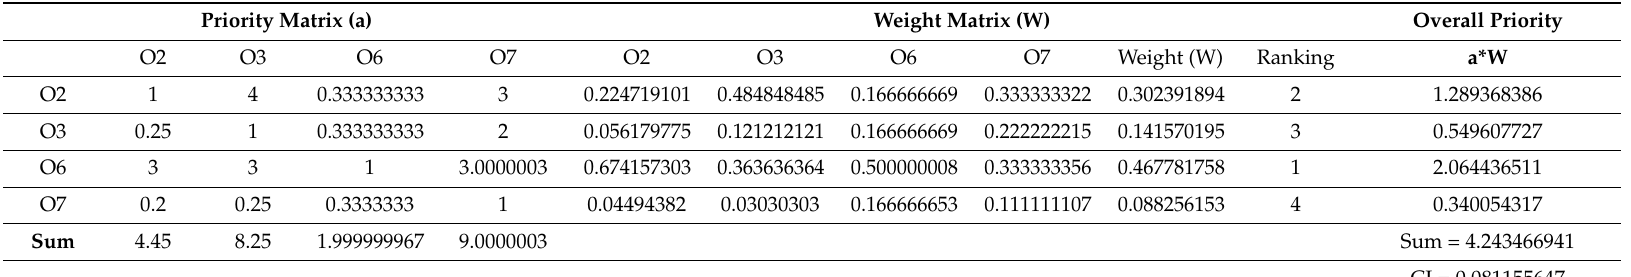
Table 5. Priority calculations for opportunity factors.